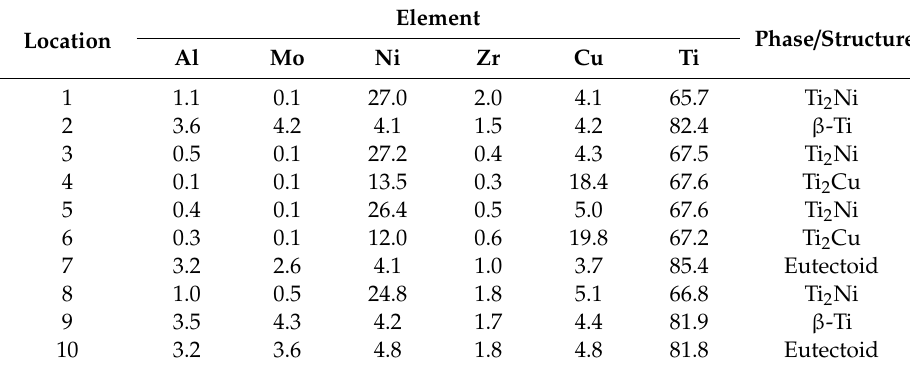
(marked 10) inside the grain likely resulted from eutectoid transformation of β -Ti in the cooling cycle of the